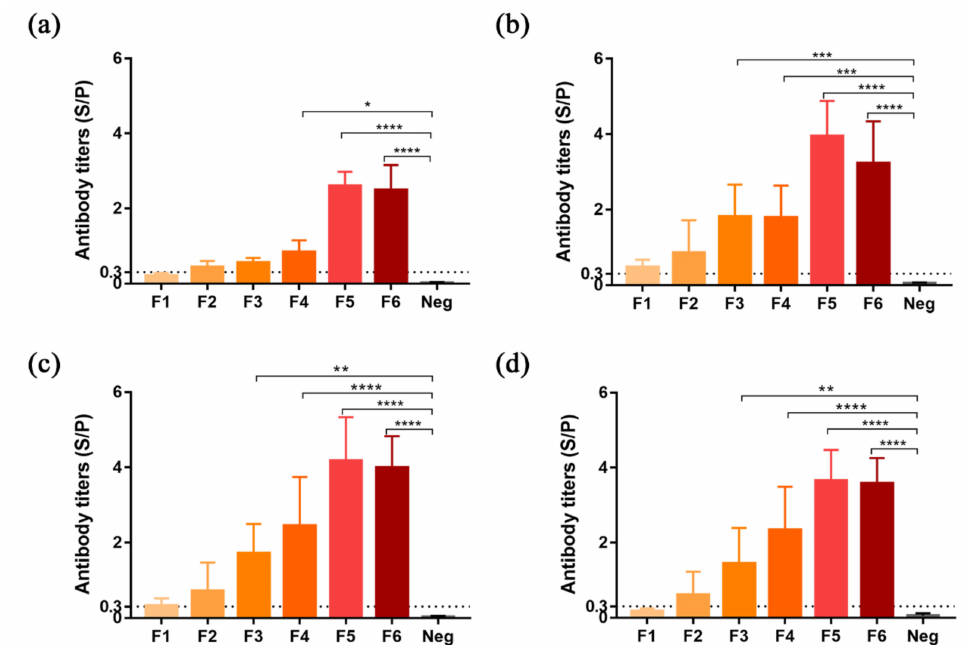
Figure 4. Immune response in chickens after receiving booster vaccination at di ff erent antigen doses. Antibody titers of di ff erent antigen dose groups on the 7th ( a ), 14th ( b ), 21st ( c ), and 28th ( d ) days after booster immunization. The F1 to F6 groups were inoculated with 0.5 µ g, 1.5 µ g, 4.5 µ g, 9 µ g, 18 µ g, and 36 µ g, respectively. The negative group (Neg) was inoculated with 36 µ g of non-transgenic rice extract. p < 0.05 (*), p < 0.01 (**), p < 0.001(***), p < 0.0001